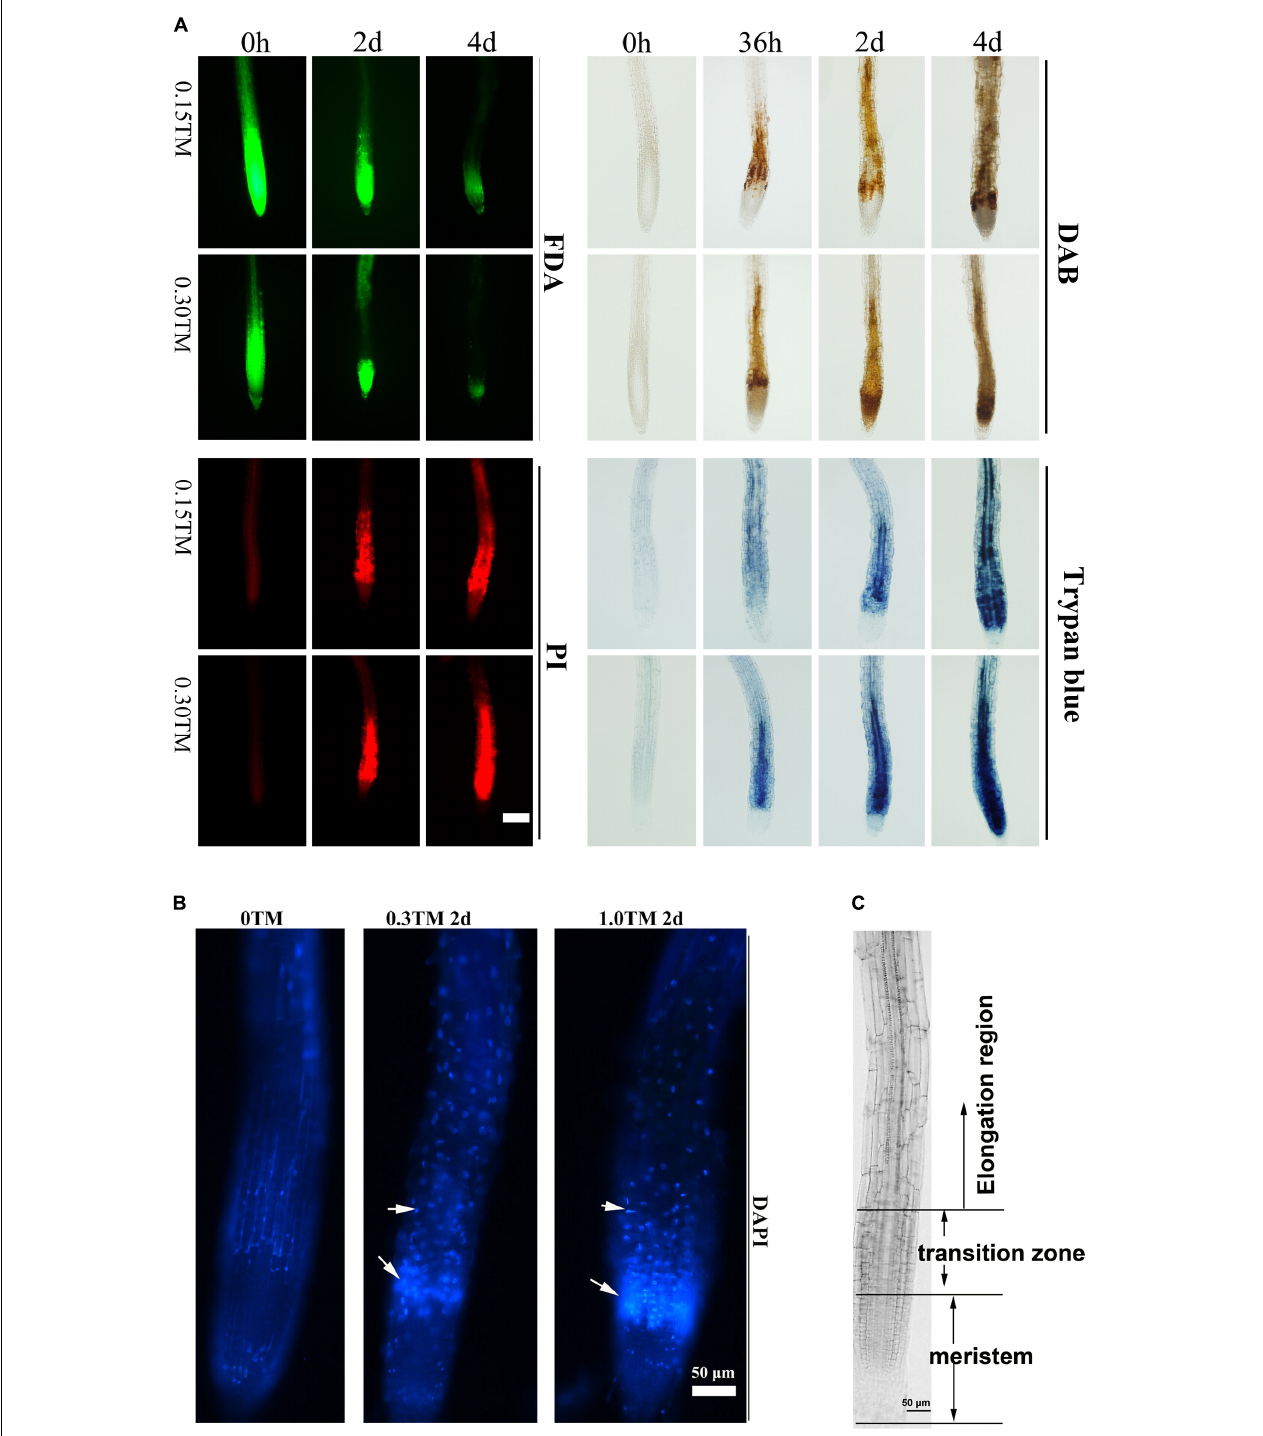
FIGURE 5 | Root cell death pattern under ER stress. (A) Time course analysis of root cell viability and ROS level upon TM treatment. The 3-day-old seedlings of vertically cultivated Col were transferred to new culture plate containing different concentrations of TM (0, 0.15, and 0.30 µ g mL − 1 ) and root cells were stained by FDA, PI, DAB, and Trypan blue after 0 h, 36 h, 2 days, and 4 days, respectively. The staining level of root on the medium without TM did not change over the time course and were same as those at “0 h”. Bar = 100 µ m. (B) Root cell death pattern stained by DAPI under ER stress. The 3-day-old seedlings of Col were transferred to a new liquid culture medium containing different concentrations of TM (0, 0.3, and 1.0 µ g mL − 1 ) for an additional 2 days and root cells were stained by DAPI. (C) Different regions of the primary root. Bar = 50 µ m.